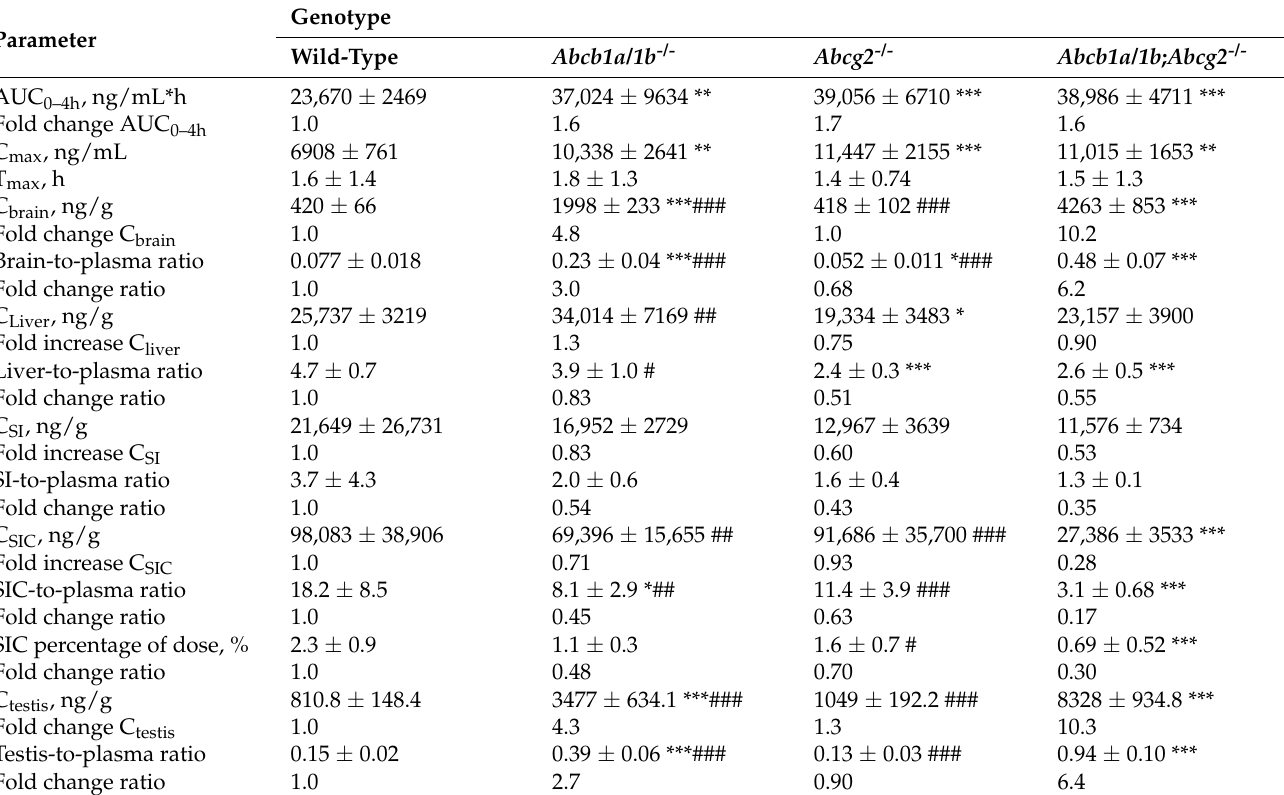
Table 2. Plasma and organ pharmacokinetic parameters of selpercatinib in male wild-type, Abcb1a/1b -/- , Abcg2 -/- and Abcb1a/1b; Abcg2 -/- mice over 4 h after oral administration of 10 mg/kg